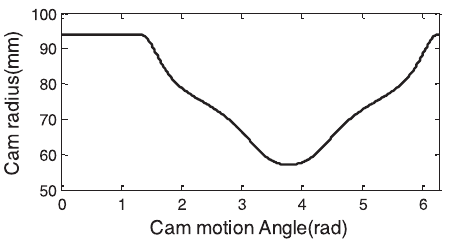
Fig. 3. Pro fi le of directional